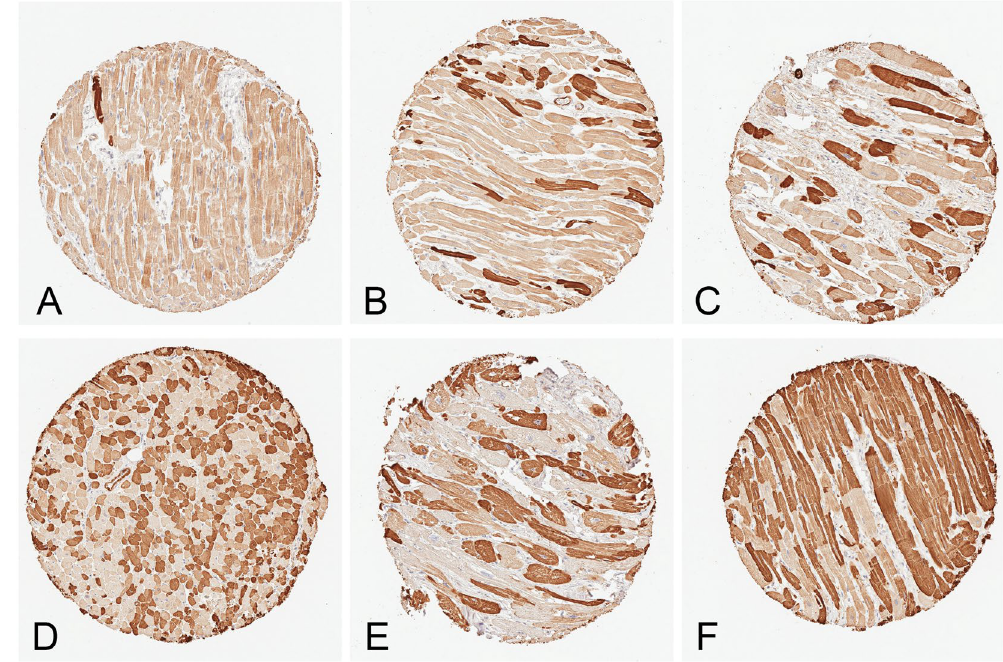
Figure 1. Representative images of mosaic MYL4 staining patterns in various cardiac diseases. ( A ) Female, sudden cardiac death, 1% MYL4 + ( B ) Female, non-cardiac cause of death, 13.8% MYL4 + ( C ) Male, ACM, 32.3% MYL4 + ( D ) Male, non-cardiac cause of death 48.2% MYL4 + ( E ) Male, hypertrophic cardiomyopathy, 55.9% MYL4 + ( F ) Male, non-cardiac cause of death 78.7% MYL4 + . All images taken from the same TMA.